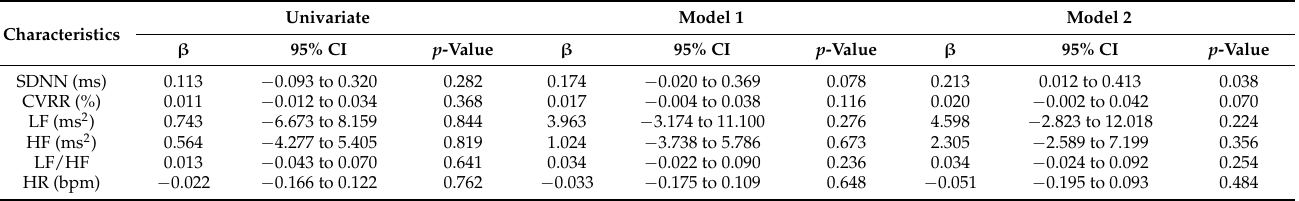
Table 3. Analysis of the association between HRV parameters and the Simpson index (%).